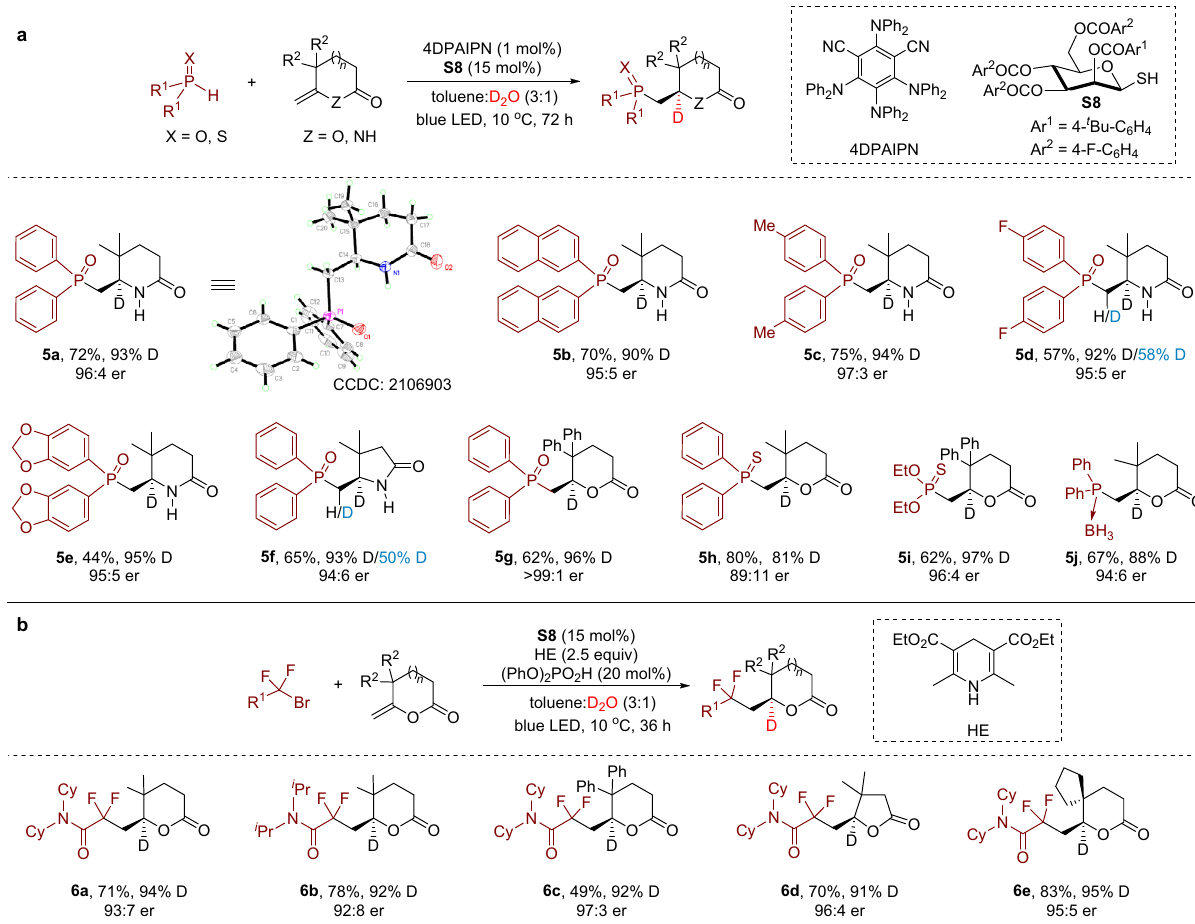
b Enantioselective deuterodi fl uoroalkylation. See Supplementary Note 2.3 for experimental